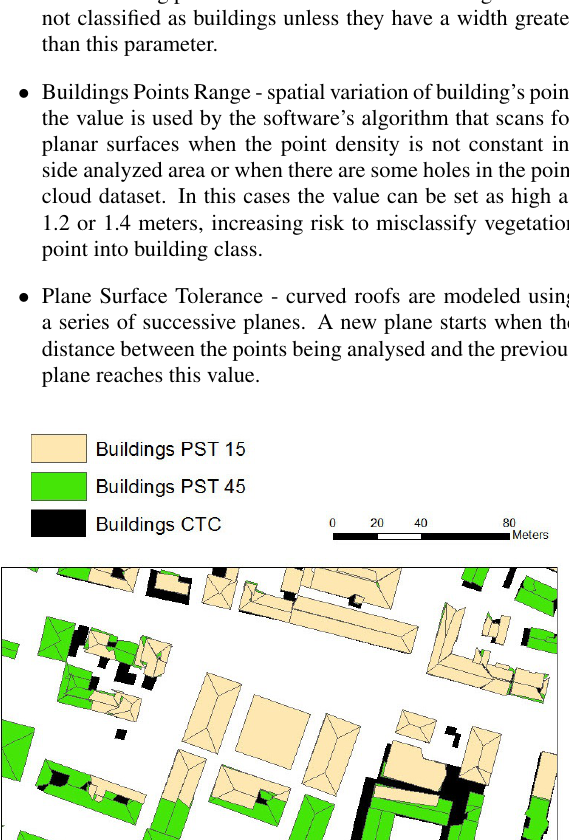
Figure 4: Different PST value with a curved surface